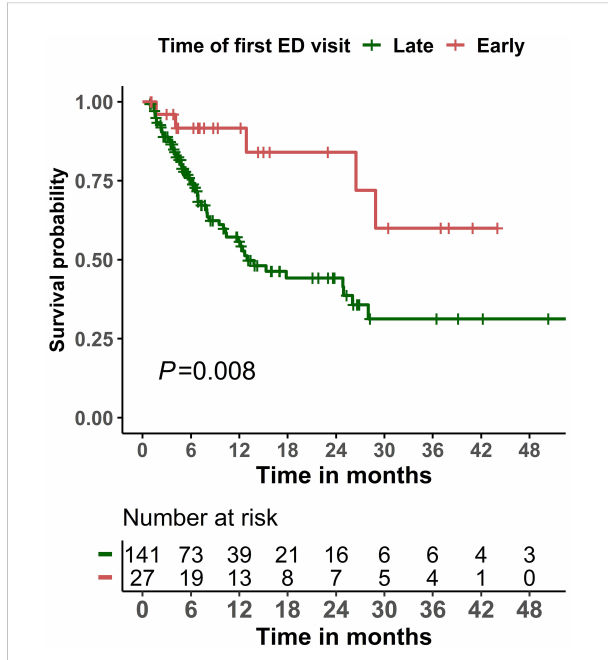
FIGURE 2 Kaplan-Meier overall survival curves among patients who visited the emergency department (ED) within 6 months of initiating chimeric antigen receptor T-cell infusion therapy, strati fi ed by timing of the fi rst ED visit (early: ≤ 14 days; late: >14